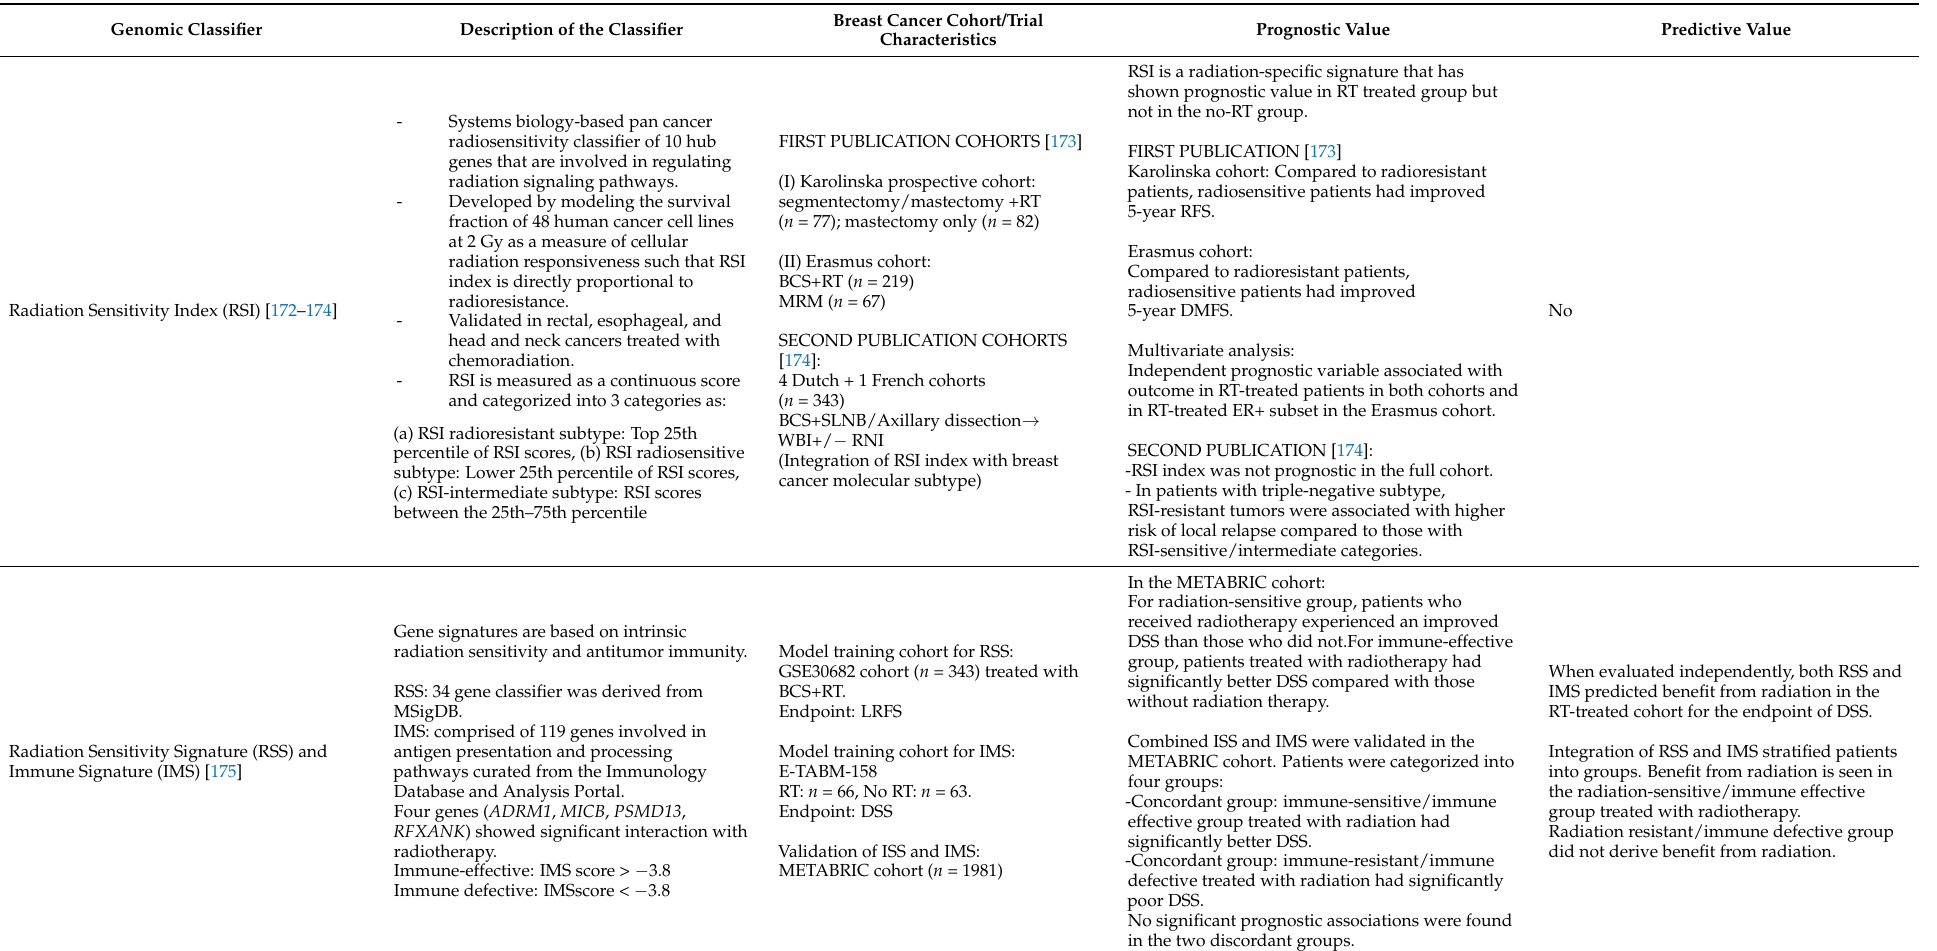
Table 3. Radiation Specific Genomic